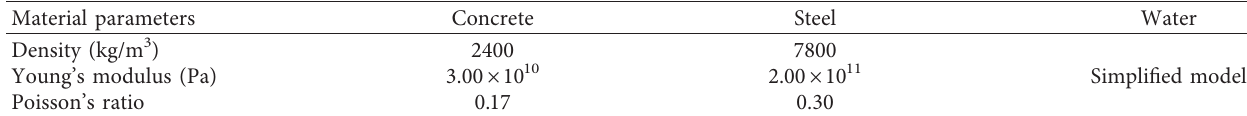
Figure 5: Numerical models: (a) model one: nonisolated structure and (b) model two: isolated structure. Table 2: Material parameters of nuclear island